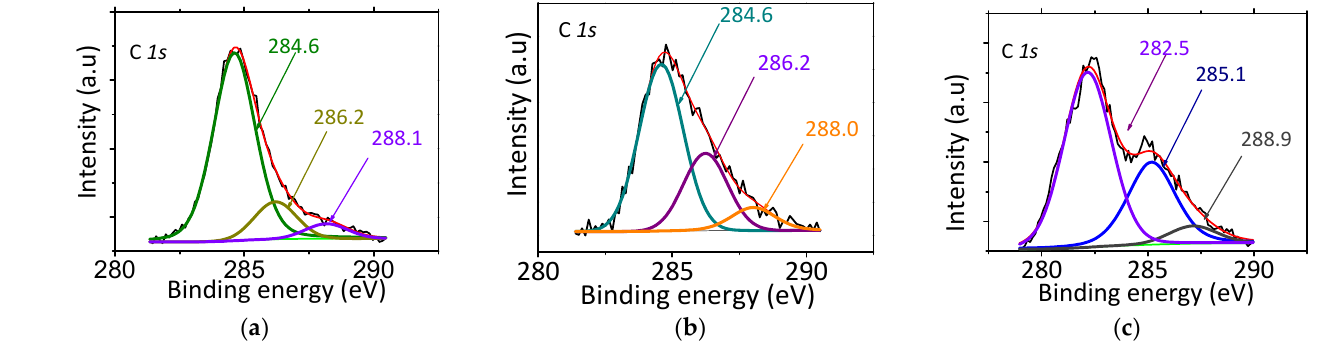
Figure 13. XPS spectra of the C 1s for ( a ) CuCa1H after the 5th cycle, ( b ) CoCu1H after the 3rd cycle, and ( c ) NiCa1H after 6 h of reaction. Reaction conditions: 75 mg of catalyst, glycerol to acetic acid molar ratio of 0.25, and reaction temperature of 80 °C.